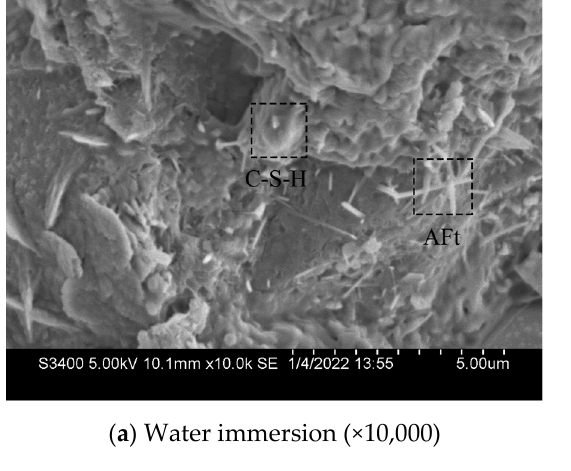
Figure 17. SEM photos of MC.